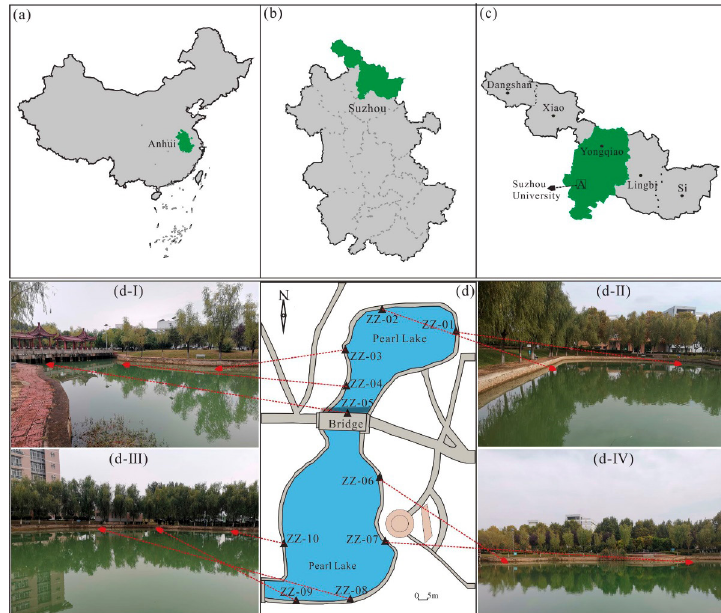
Figure 1. Study area location (Pearl